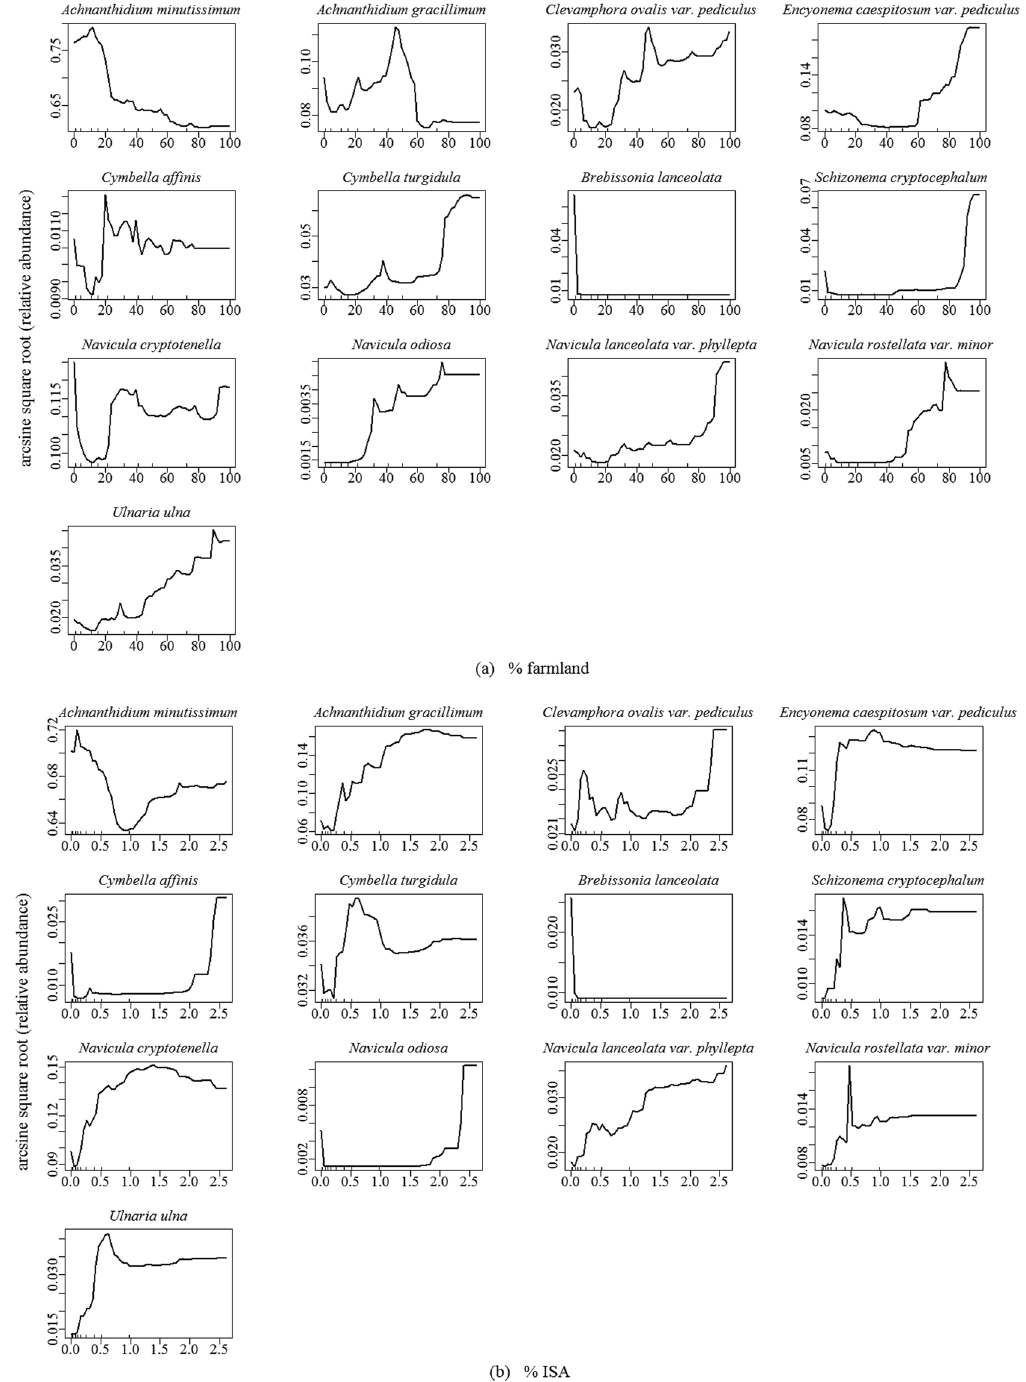
Figure 5. Partial dependence plots for random forest predictions of changes in relative abundance of selected diatom taxa across the gradient of watershed % farmland ( a ) and % impervious surface area (% ISA) ( b ) in tributaries of the Three Gorges